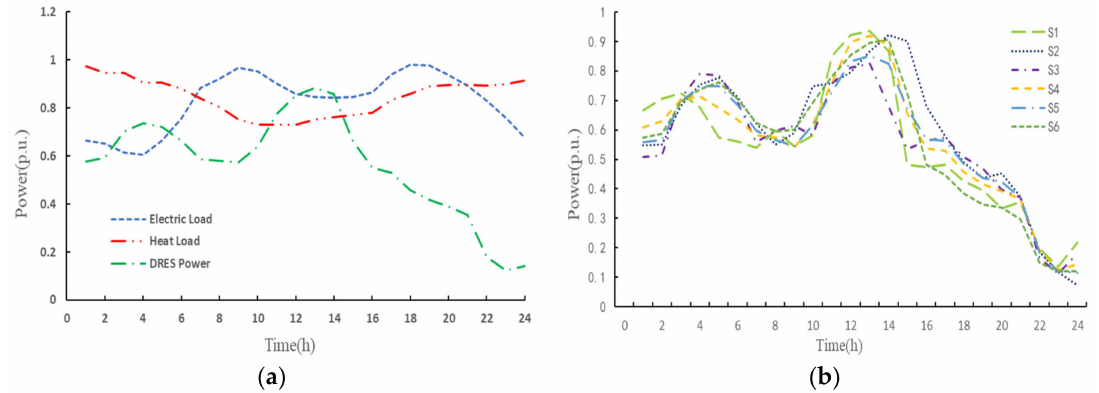
Figure 3. ( a ) DRES joint output and power / heat demand day-ahead forecast curve; ( b ) actual output of DRES under di ff erent